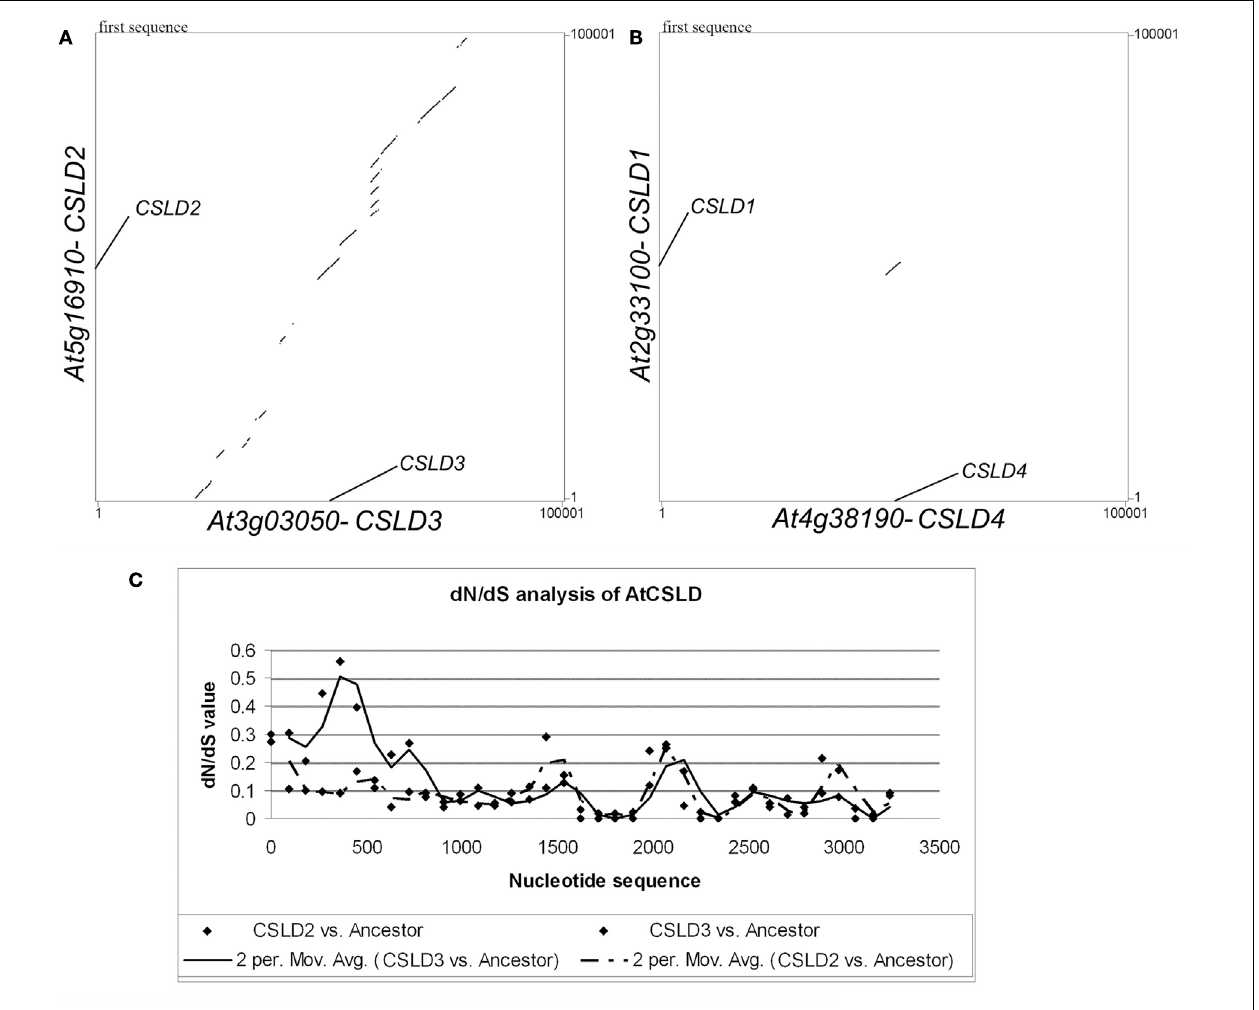
FIGURE 7 | Sequence analyses of CSLD genes. (A) Dot-matrix analysis comparing the flanking genomic regions (50kb on both sides) of CSLD2 and CSLD3 . (B) d N /d S sliding-window (window size 180, movement 90) analysis of CSLD2 (dash line) and CSLD3 (solid line) with their predicted common